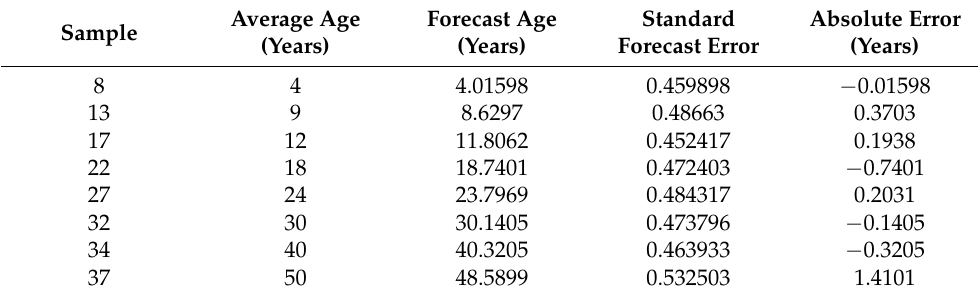
Table 12. Validation of the model O5 with eight of the analyzed Oloroso Sherry wine samples.